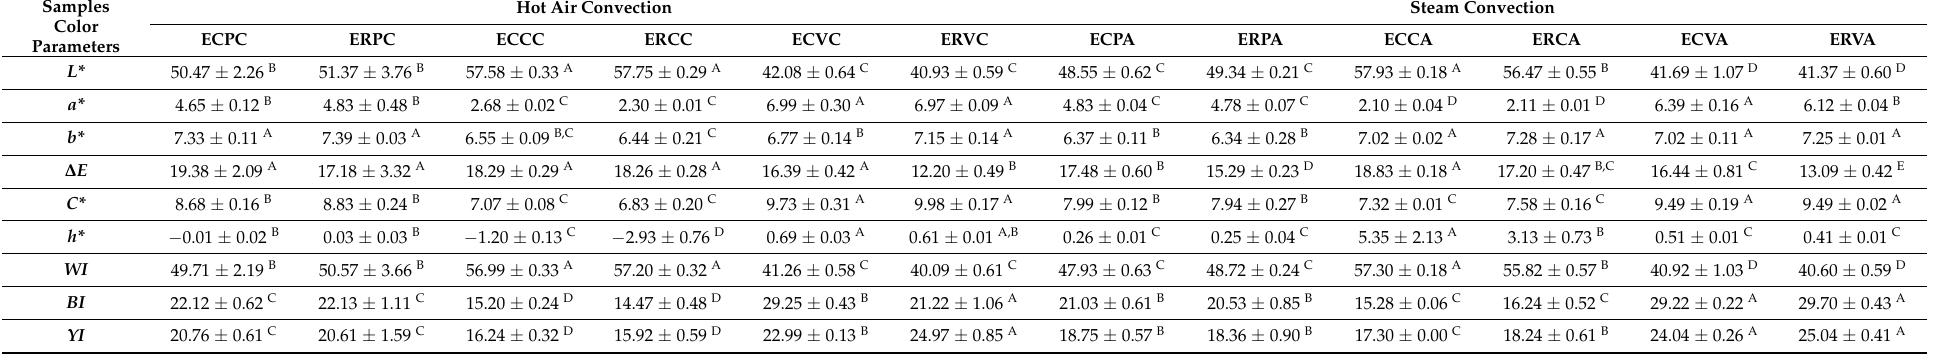
Table 2. Effects of heat treatment on the color parameters of aqueous extract enriched meatballs.